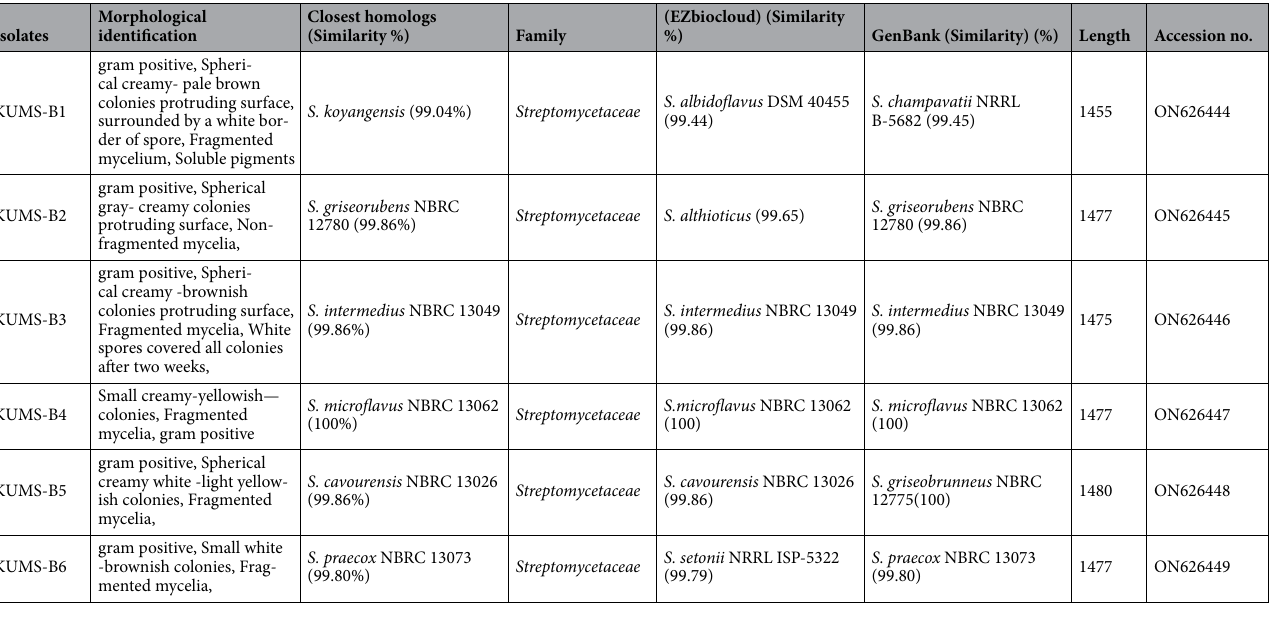
Table 1. Identification of endophytic actinobacteria isolates from Luffa cylindrica . The table summarizes the accession no of isolates, and their homology, family and closely related